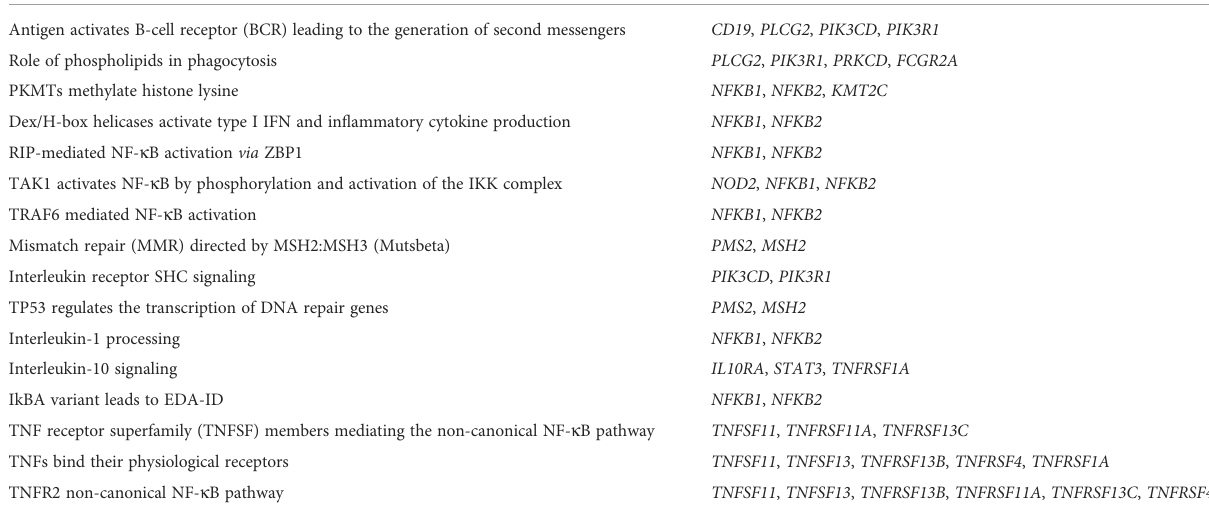
TABLE 4 Relationships organized in biological pathways and processes mainly related to CVID-associated genes expressed in NHL (sorted by p -value; p < 0.05). Associated pathways of CVID genes Related